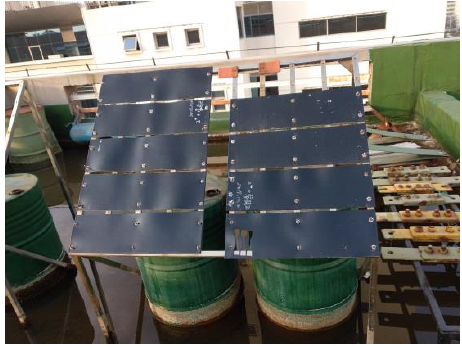
Figure 2. Qingdao University of Technology exposure site.